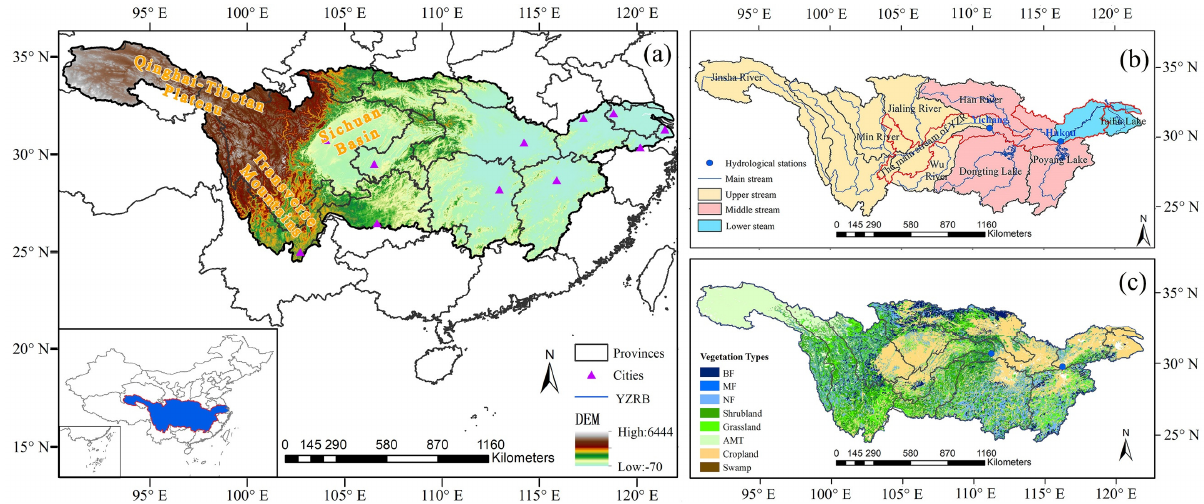
Figure 1. The Yangtze River Basin (YZRB): ( a ) location and elevation; ( b ) subbasins; and ( c ) vegetation types.